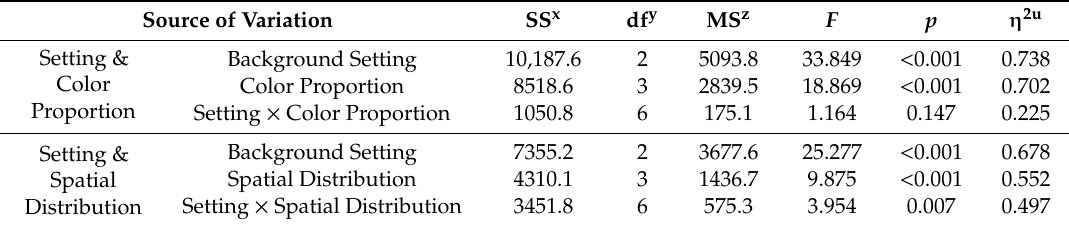
Figure 6. The mean value of different proportions of design color effects on visual aesthetic quality (VAQ) of three landscape background types (Mixed: Sophora japonica and Juniperus chinensis , Broadleaf: Sophora japonica , Narrowleaf: Juniperus chinensis ). C 25 accounts for 25% red of the midground; C 50 accounts for 50% red of the midground; C 75 accounts for 75% red of the midground; C 100 accounts for 100% red of the midground. Lower case letters were used to compare the di ff erence among C 25 , C 50 , C 75 , and C 100 . Table 5. Interaction terms by a mixed two-way ANOVA with repeated measures (“Setting × Color Proportion” and “Setting × Spatial